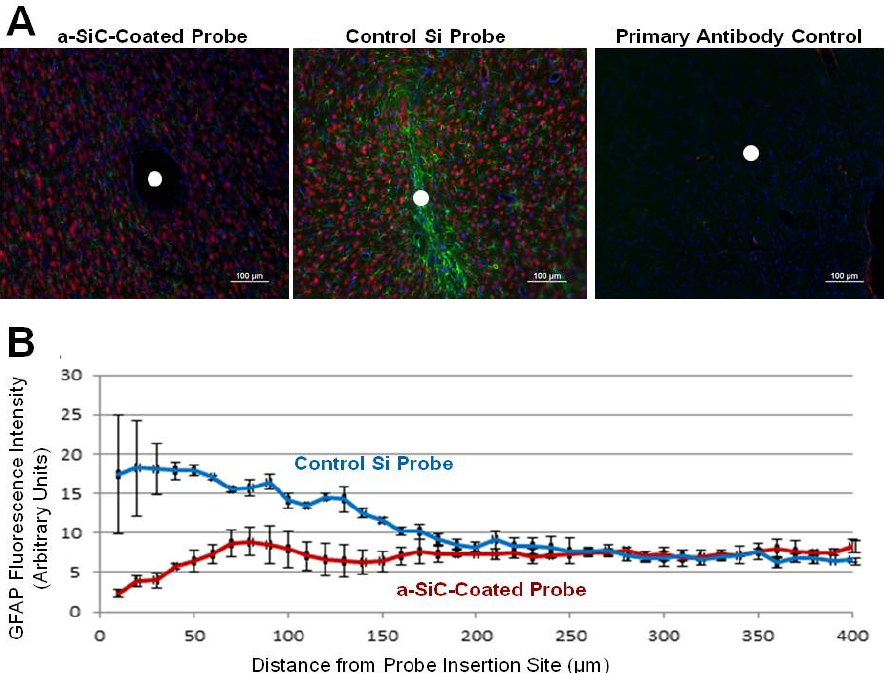
Figure 5. ( A ) Images from deep cortical tissue labeling NeuN in red (neurons), GFAP in green (astrocytes), and DAPI in blue (cell nuclei). White circles indicate center of probe locations. Left image is from tissue implanted with an a-SiC-coated probe, middle from a control Si probe, and the right image is the no primary control, indicating little or no non-specific antibody binding. ( B ) Immunohistochemistry summary data comparing results from a-SiC-coated (red) and control Si (blue) probe after implantation for four weeks. Data are mean ± SEM for n = 2 slices [3].